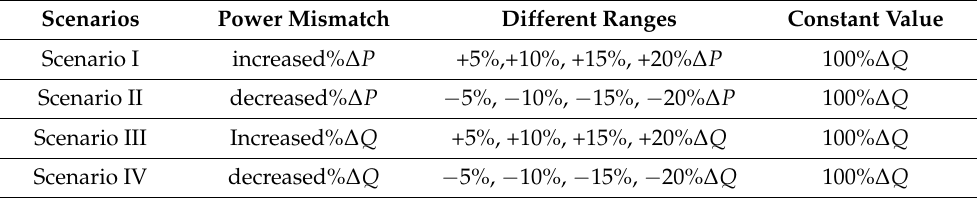
Figure 9. Case2, Scenario III: the results of analysis for increased reactive power mismatch, ( a )Voltage at PCC; ( b ) frequency at PCC; ( c ) output of the proposed DEDFOR detector; ( d ) the trip signal for CB1. A summary of the results is provided in Table 3. Table 3. Various islanding condition for different power mismatches.